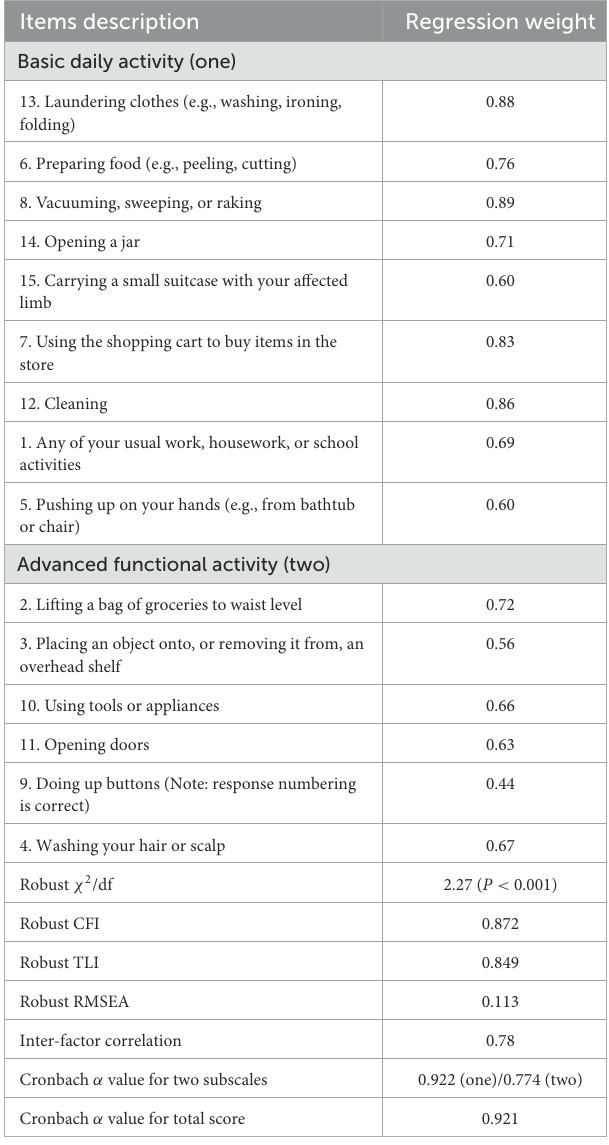
TABLE 7 Confirmatory factor analysis and item statistics of the C-UEFI ( N =